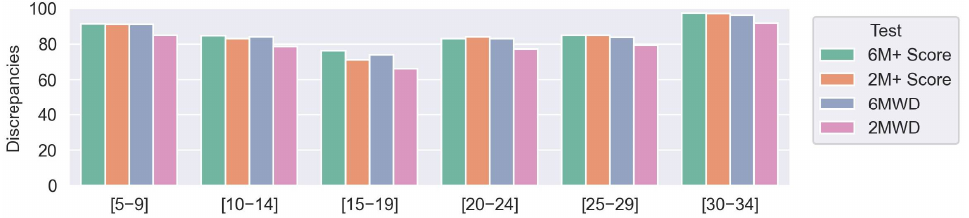
Figure 8. Discrepancies for different NSAA ranges, for 6 and 2 min scores (6M+ and 2M+, respec- tively), 6MWT, and 2MWT in comparison with NSAA score, computed as depicted in Equation (1). The regression with the ages of the patients is shown in Figure 9. As a progressive disorder, it is expected to have a negative correlation with age. The 6M+ and 2M+ scores were the most negatively correlated with age (with R 2 values of 0.41 and 0.49, respectively), with higher values than the NSAA score.